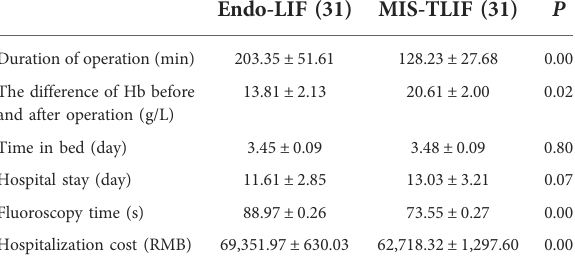
TABLE 3 Comparison of ODI, VAS, and JOA scores in the